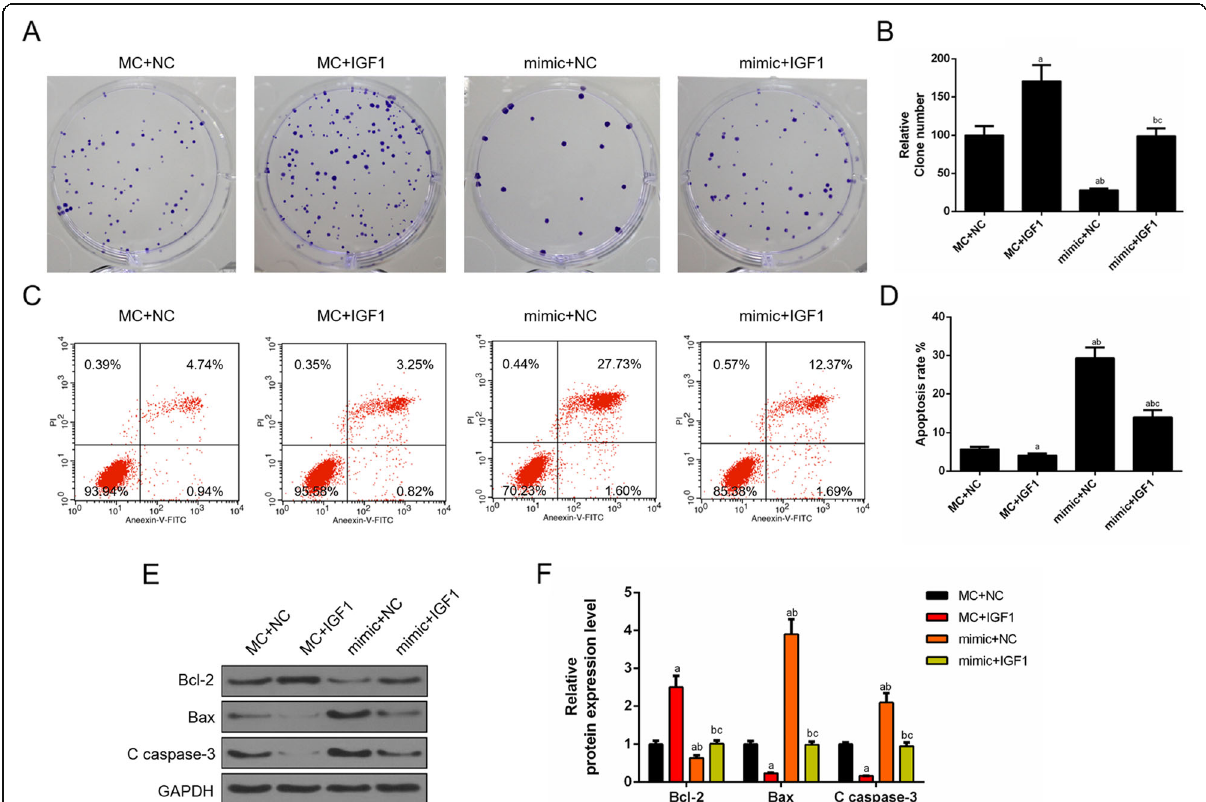
Fig. 8 Restored IGF1 expression improved the suppressive effects of miR-126 overexpression in cell proliferation and attenuated the promotion effects of miR-126 overexpression in cell apoptosis. ( a ) Co-transfecting miR-126 mimic and IGF1 promoted cell proliferation as shown by cloning formation experiment. ( b ) The number of proliferated cells was quantified. ( c ) Cells apoptosis was triggered by miR-126 mimic, which partially reversed by IGF1. ( d ) The proportion of apoptosis was quantified. ( e ) The apoptosis-related proteins (Bcl-2, Bax and c caspase 3) were detected by Western blot. ( f ) The relative levels of proteins described in ( e ) were counted by GAPDH as normalization. a P < 0.05 vs. MC + NC, b P < 0.05 vs. MC + IGF1, c P < 0.05 vs.